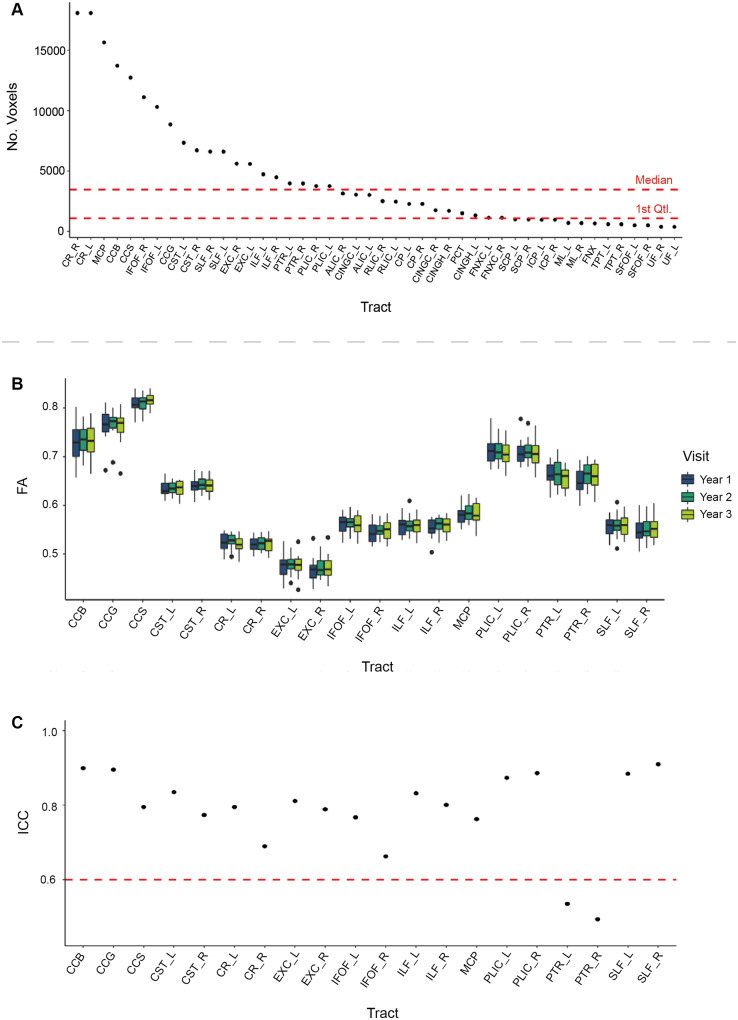

Data-driven tract selection. (A) Voxel size of all 46 candidate tracts ordered from largest to smallest. Median and first interquartile range demonstrated on red dashed lines. (B) Mean FA in each of the remaining candidate tracts across a longitudinal healthy control population (n = 20). (C) Reliability of tracts calculated using ICC using longitudinal data from healthy control subset. See Supplementary Table 3 for tract abbreviations and associated acronyms.